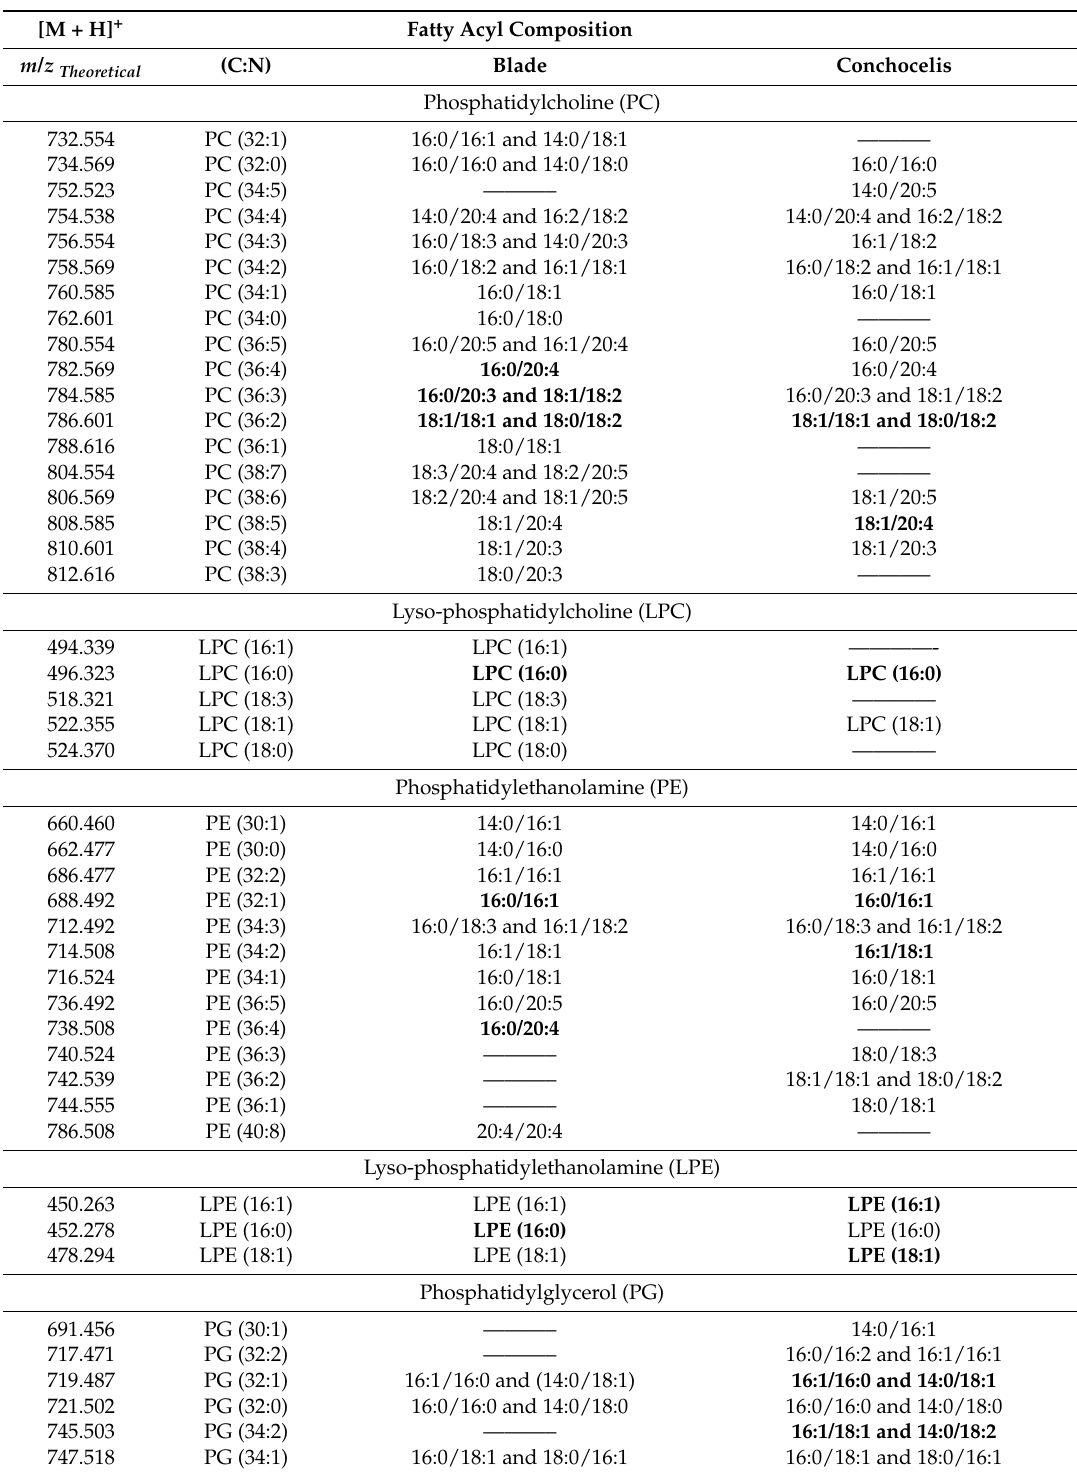
Table 3. Identification of phospholipids in the lipidome of blade and conchocelis stages of